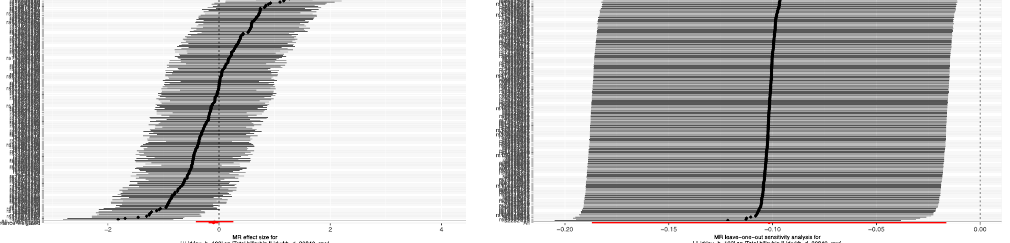
Figure 4. The significant causal effect of MDD on total bilirubin ( A ) and ADHD on ascorbate ( B ). ( A ) Significant causal effect of ADHD on ascorbate; ( B ) significant causal effect of MDD on total bilirubin. UA, uric acid; MDD, major depressive disorder; ADHD, attention-deficit/hyperactivity disorder. There were nominal associations between BD and retinol (beta = 0.018, 95% CI ranges from 0.011 to 0.025, p = 0.014; p of egger intercept = 0.265), while the relationship